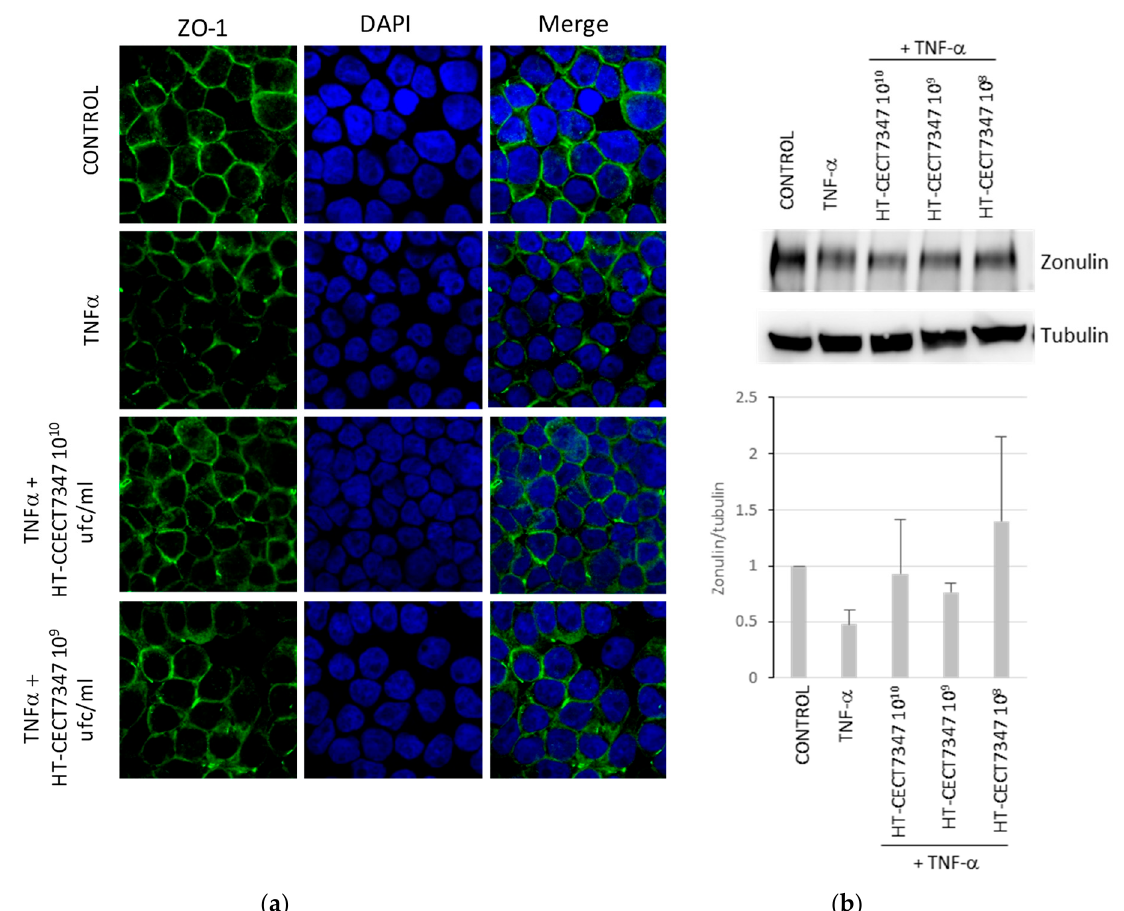
Figure 7. Analysis of the effect of HT-CECT-7347 on zonulin localization on TNF- α -stimulated in HT-29 cells. ( a ) Representative images from immunofluorescence analysis of zonulin (green fluorescence AlexaFluor 488) in TNF- α stimulated cells show a significant decrease in staining of ZO-1. Localization of ZO-1 is not affected when cells are stimulated by TNF- α in the presence of HT-CECT-7347. Micrographs were captured at 60× magnification. ( b ) Western blot analysis for zonulin levels in cell extracts of HT-29 cells treated with TNF- α with or without HT-CECT-7347. Expression results were quantified by Image Studio software (LI-COR Biosciences) and represented as a graph. Data represents the means (+/ − SD) of two independent experiments.